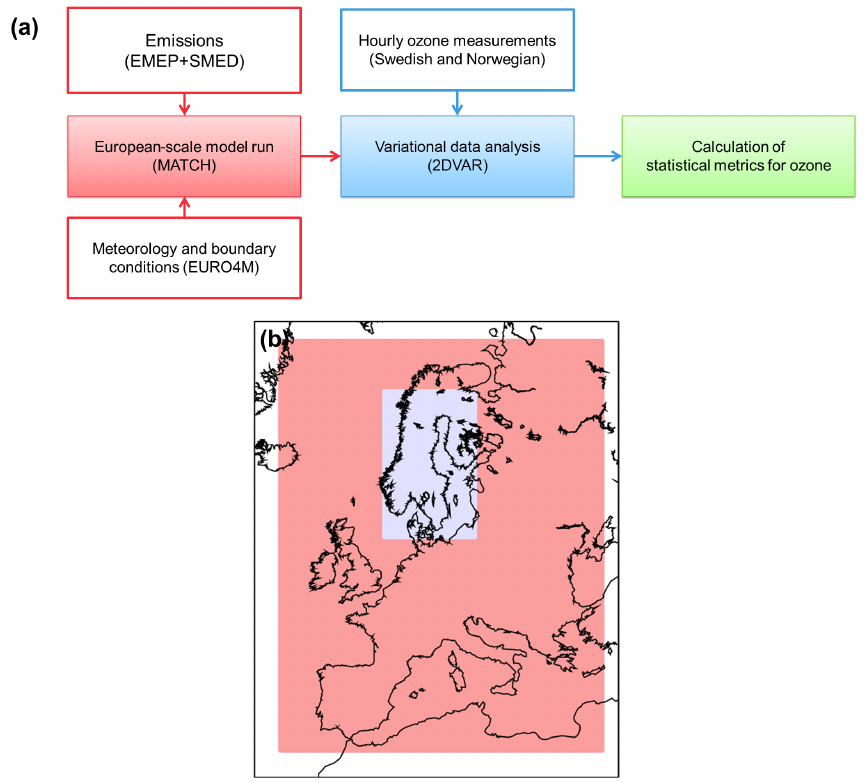
Figure 1. (a) A flow-chart of the relevant part of the MATCH Sweden system for this reanalysis study. (b) The total domain of the European scale model run (pink + light blue) and the domain of the variational data analysis (light